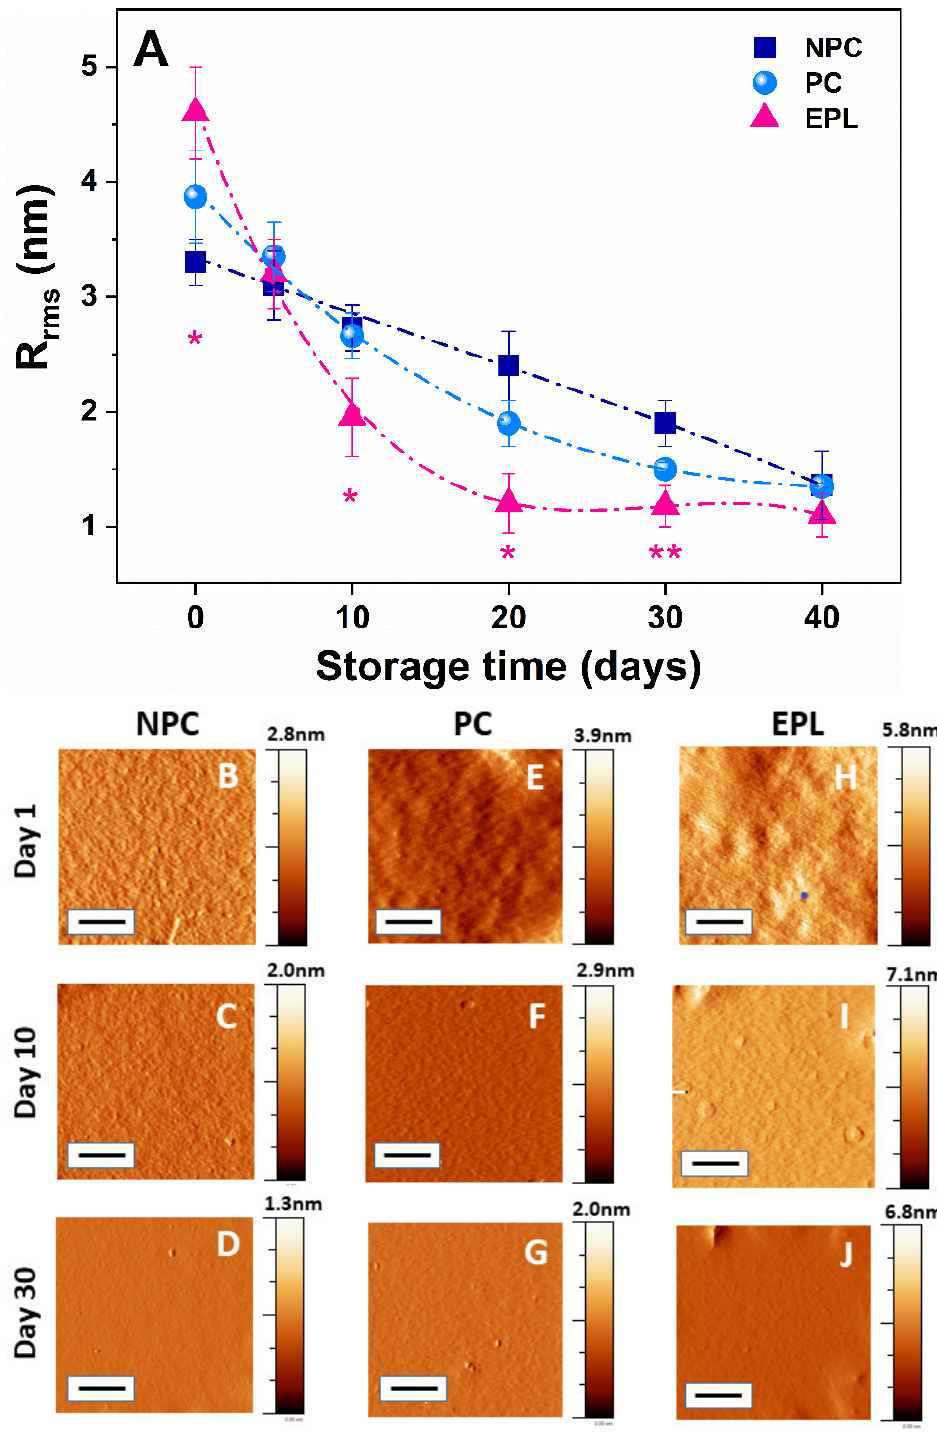
Figure 5. The calculated value of R rms of the plasma membrane as a function of cell storage time ( A ) and the ultrastructural changes over time of erythrocytes membranes of cells from nonpregnant controls (NPC) ( B – D ); pregnant controls (PC) ( E – G ); and women with early pregnancy loss (EPL) ( H – J ). The scale bars indicate 500 nm. Non-parametric Wilcoxon test was used to determine statistical differences in R rms value of EPL cells, which are given as p values, indicated as * p < 0.05 relative to both NPC and PC, ** p < 0.05 relative to NPC.